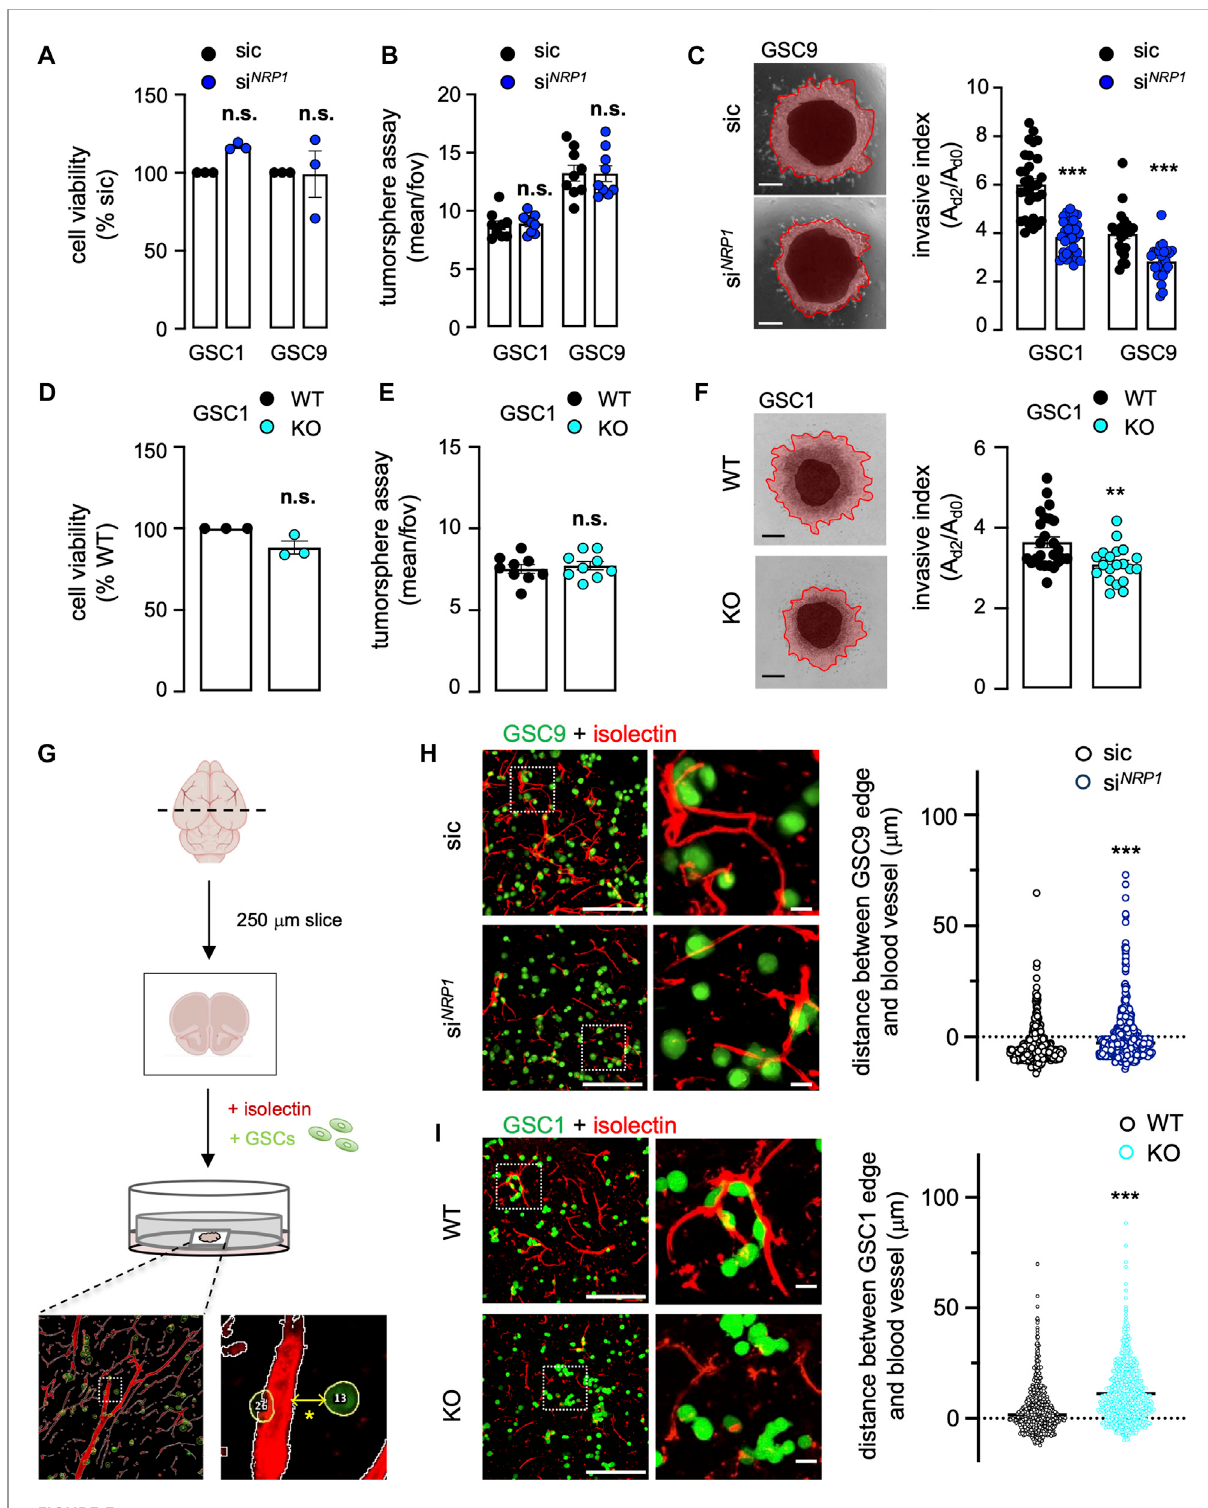
FIGURE 3 Neuropilin1 expression modulates patient-derived GSC 3D cell invasion. (A – C) Glioblastoma stem-like patient-derived cells (GSC1 and GSC9) were transfected with non-silencing (sic, black) and NRP1 targeting duplexes (si NRP1 , dark blue). Cell viability was measured using CellTiterGlo on day 3. Data were normalized to sic and are presented as the mean ± s.e.m. of three independent experiments in triplicate (A) . Tumorspheres per fi eld of view (fov) were single-blinded and manually counted. Data are presented as the mean ± s.e.m. from three independent experiments